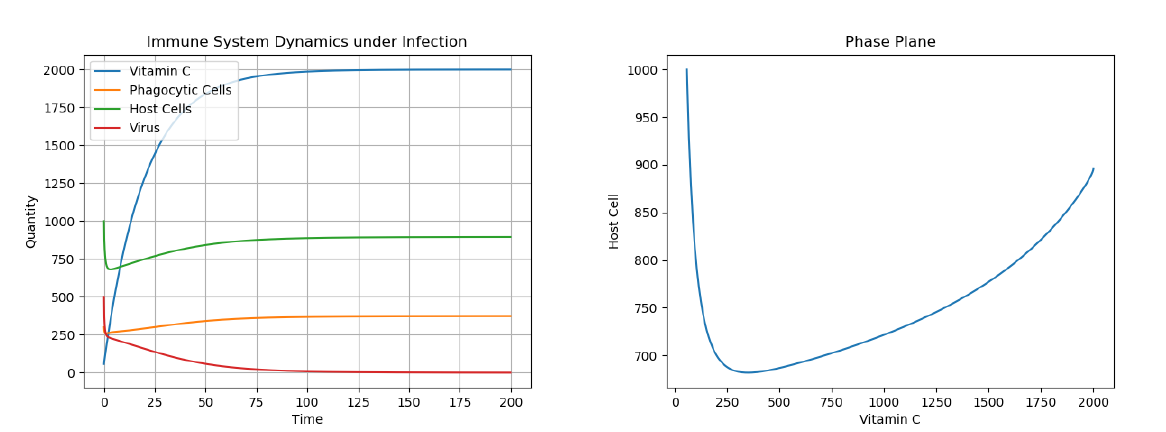
Figure 1. Dynamics under Viral Infection with Extreme Constant Infusion of Vitamin C